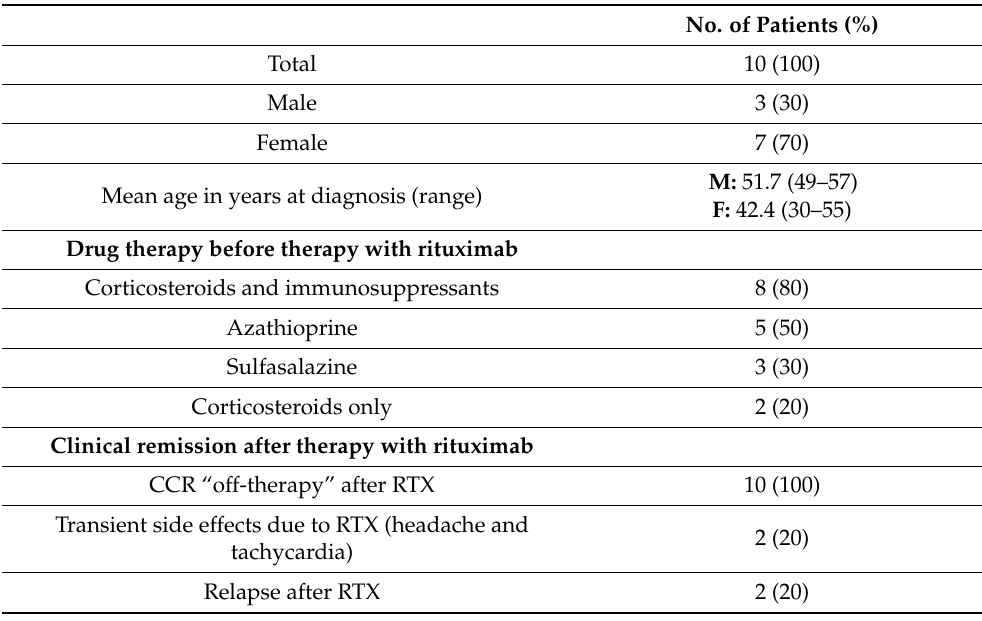
Table 1. Patients’